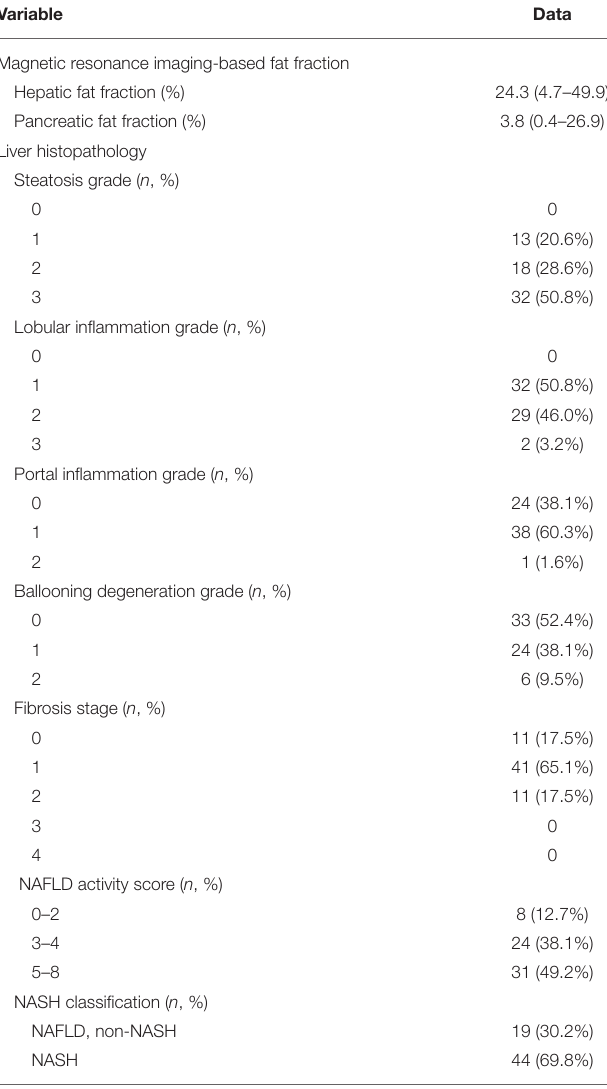
TABLE 1 | Magnetic resonance imaging based-fat fractions and histopathologic features of the liver in 63 children with non-alcoholic fatty liver disease.